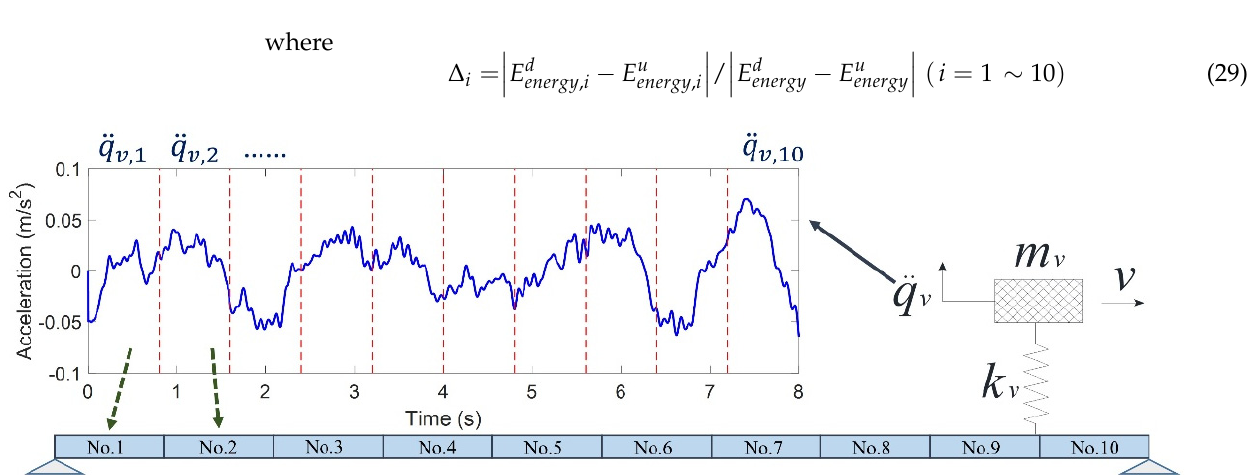
Figure 2. Divide the vehicle acceleration signal .